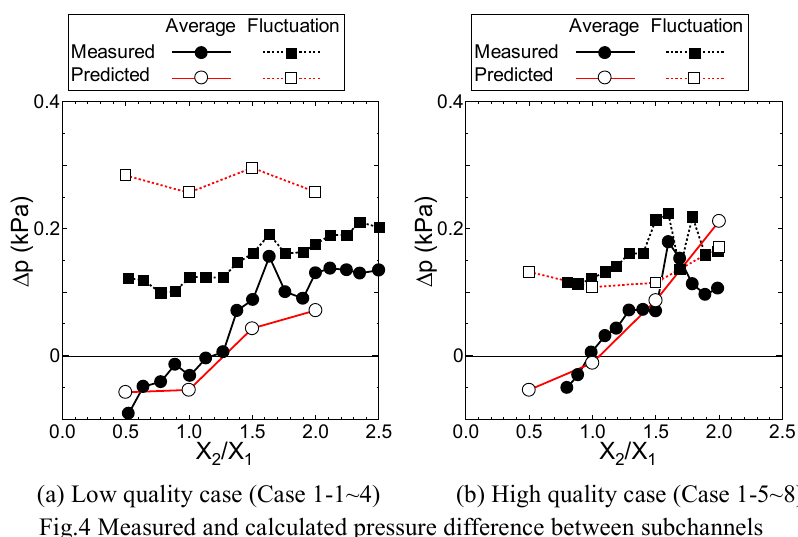
Fig.4 Measured and calculated pressure difference between